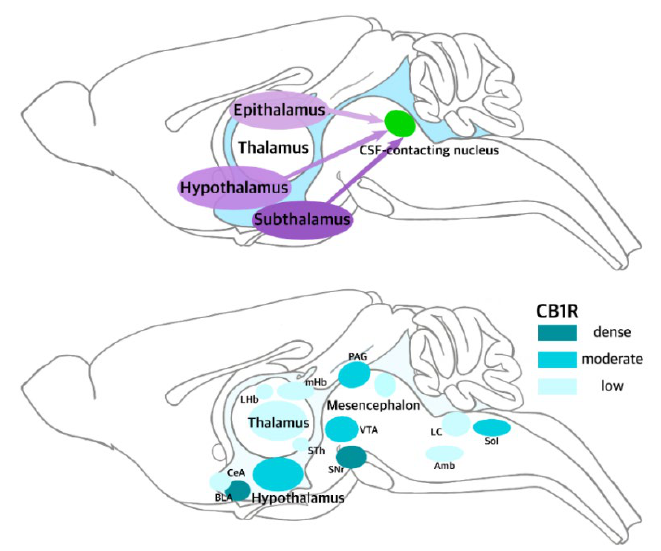
Scheme 4. The upper schematic diagram shows projections of the connections of the mesencephalon, thalamus, and hypothalamus (epithalamus and subthalamus) to the cerebrospinal fluid-contacting nucleus (CSF-contacting nucleus). The lower diagram shows the distribution of CB1Rs in these areas of the diencephalon and brainstem. The distribution of CB1Rs is indicated by the circular shapes with low (pale turquoise), moderate (light turquoise), and high (dark turquoise) expression. Data for figures were taken and adapted from Song (© 2020 Song, Li, Zhai, Li, Bao Shan, Hong Cao and Zhang) ([25] and Befort (©Befort) [61] under the terms of the Creative Commons Attribution License (CC BY).